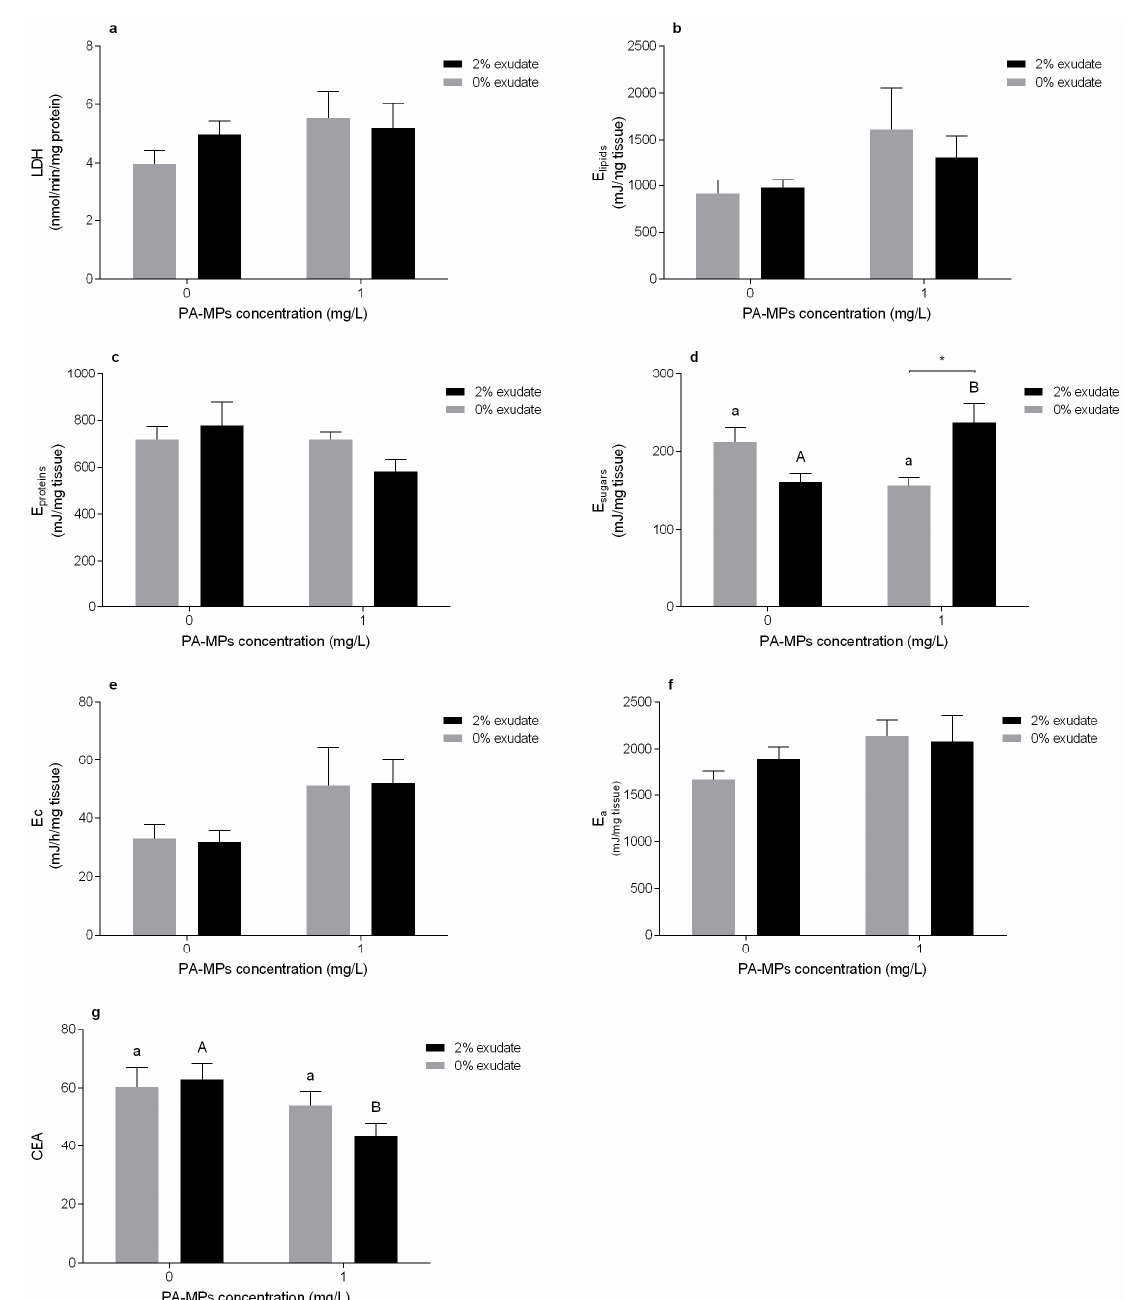
Figure 4. Energy metabolism biomarkers of Mytilus galloprovincialis muscles after 96 h of exposure to A. armata exudate (0% and 2%) at different polyamide microplastic concentrations (0 and 1 mg/L). ( a ) Lactate dehydrogenase (LDH), ( b ) lipid contents (E lipids ), ( c ) protein contents (E proteins ), ( d ) sugar content (E sugars ), ( e ) electron transport system, ( f ) energy available (Ea), and ( g ) cellular energy allocation (CEA). All values are presented as mean ± SEM. * denotes a significant difference between the 0% and 2% A. armata exudate in the same PA-MPs concentration. The upper-case letters indicate differences in the 0% exudate treatments and the different lower-case letters represent differences in the 2% exudate treatments at the different PA-MPs concentrations.